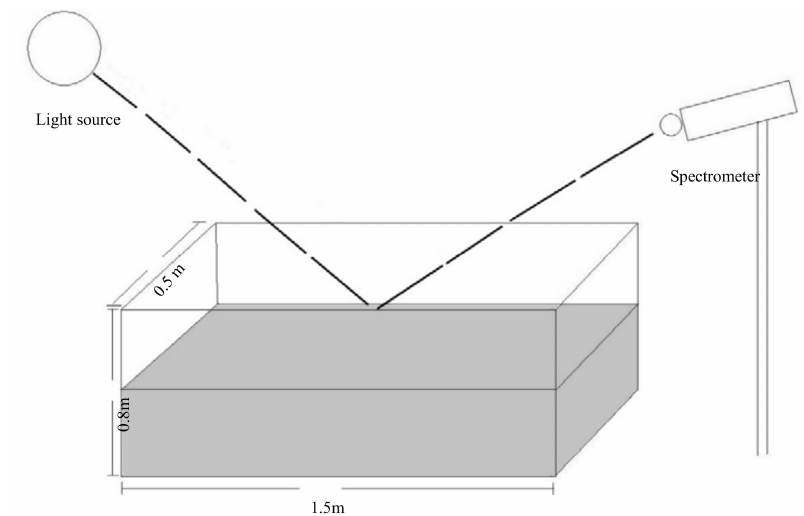
Figure 1. Color spectrum measurement system for water landscape. Light source is the natural light source of the sun. Spectrometer is a hyperspectral